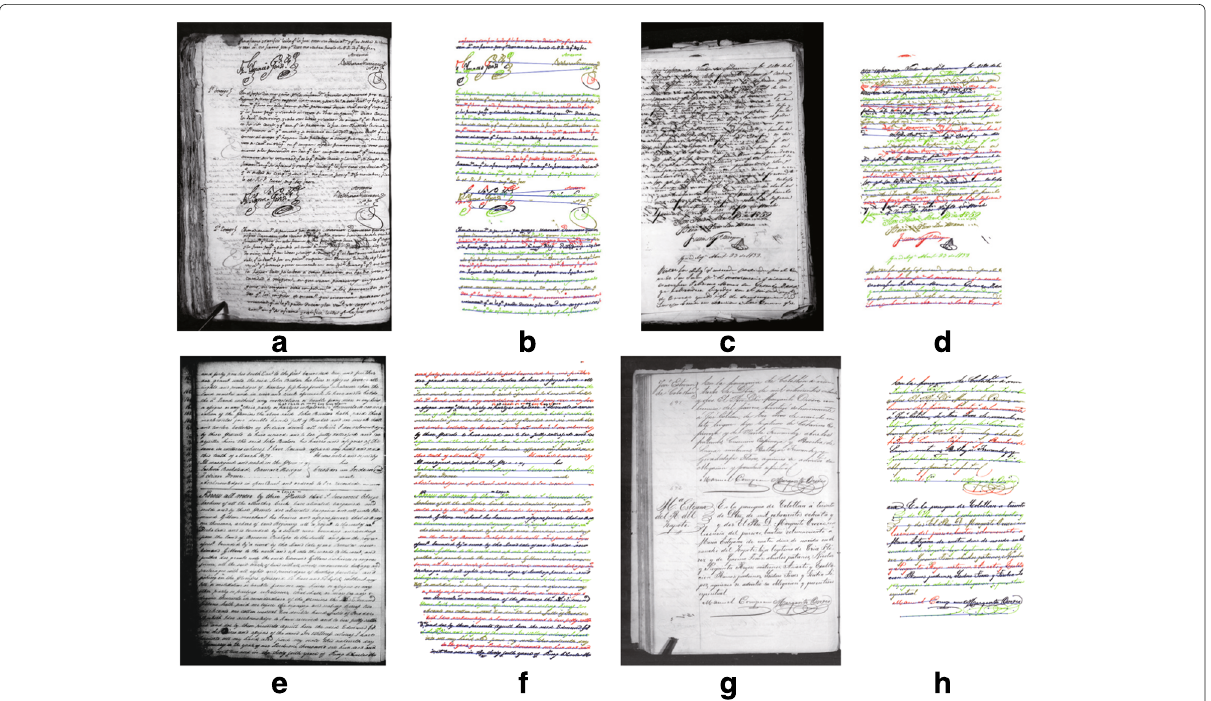
Fig. 9 Failure cases of the proposed method in the ICDAR 2015 dataset [18], ( a , c , e , g ) Samples from ICDAR 2015 dataset, ( b , d , f , h ) corresponding